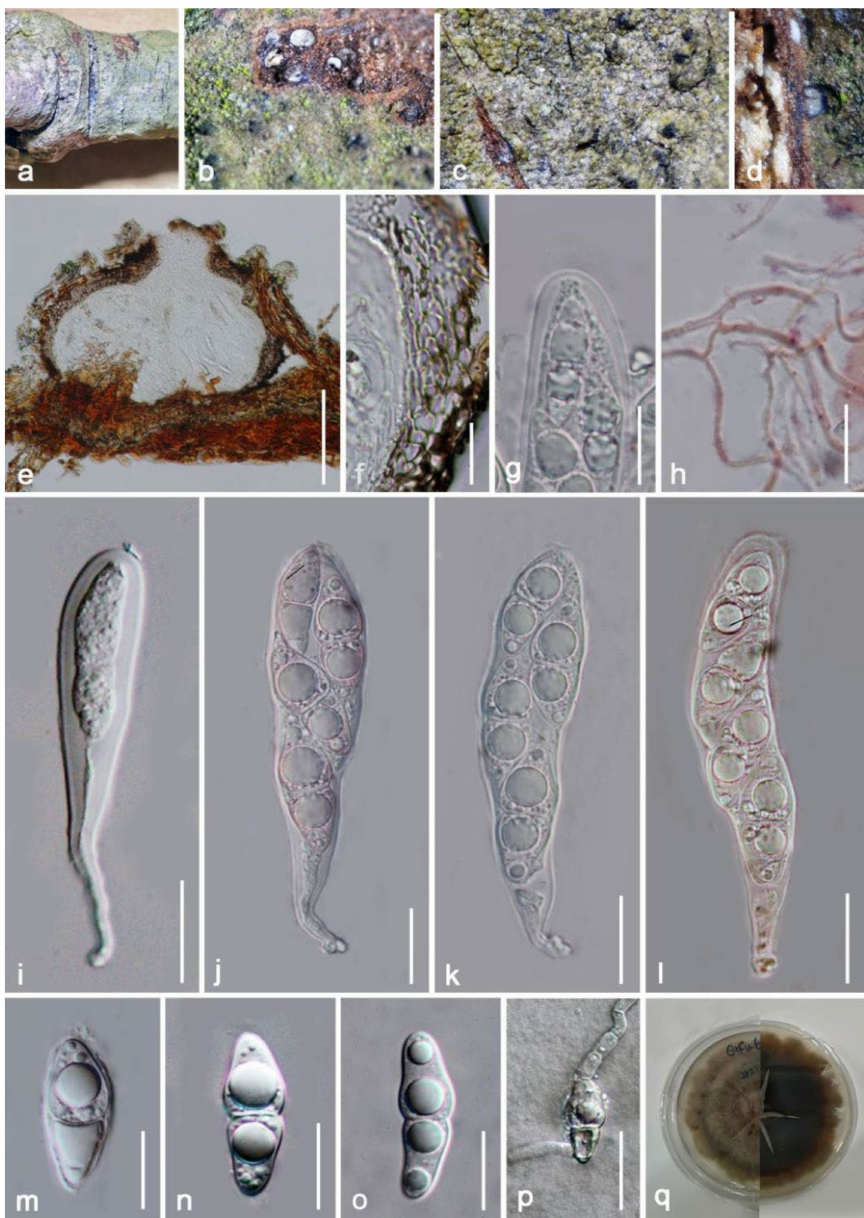
Figure 18. Crassiparies quadrisporus (HKAS 122192). ( a ) Ascomata immersed in the dead wood of Mangifera indica ; ( b – d ) exposed ascoma after section; ( e ) vertical section of ascomata; ( f ) peridium; ( g ) apical chamber of asci; ( h ) pseudoparaphyses strained with congo red; ( i , k ) asci; ( j , l ) asci stained by congo red; ( m , n ) ascospore; ( p ) germinated ascospore; ( q ) colonies on PDA. Scale bars: ( e ) = 150 µ m; ( p ) = 30 µ m; ( i – l ) = 20 µ m; ( f – h , m – o ) = 15 µ